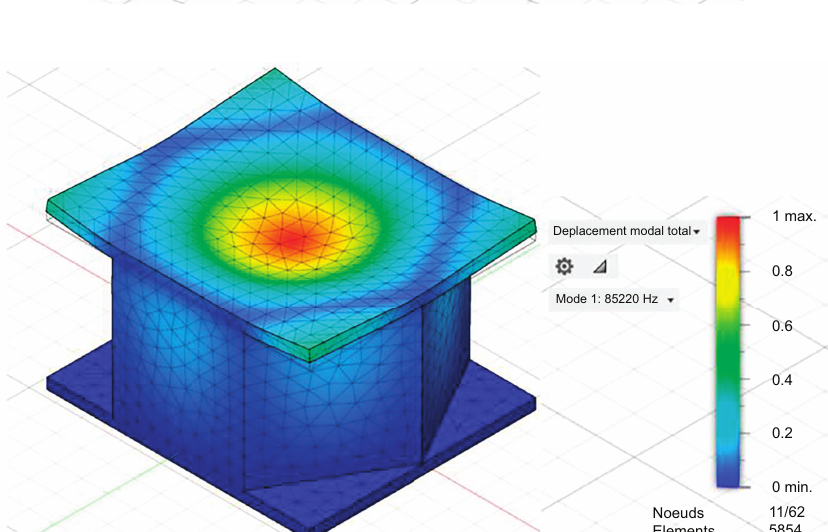
Figure 6. Mesh of the unit cell